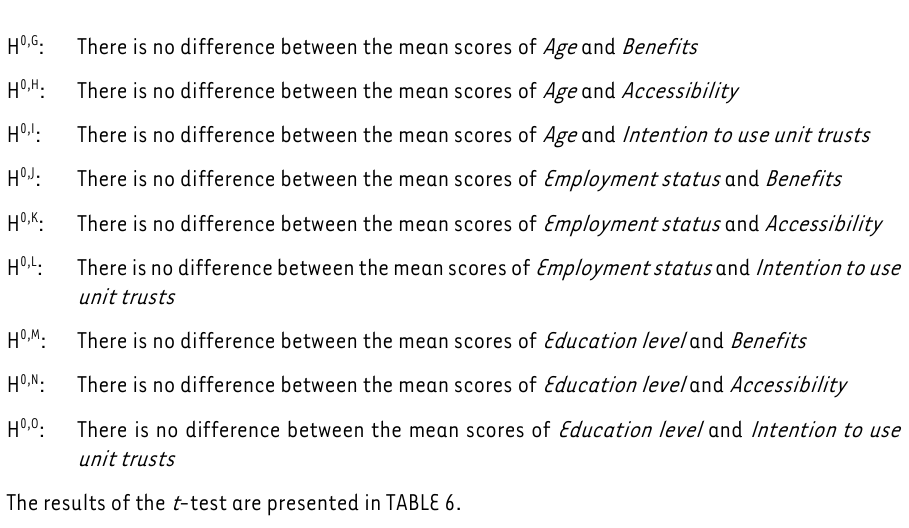
TABLE 6: T-test summary of Gender on the independent and dependent variables